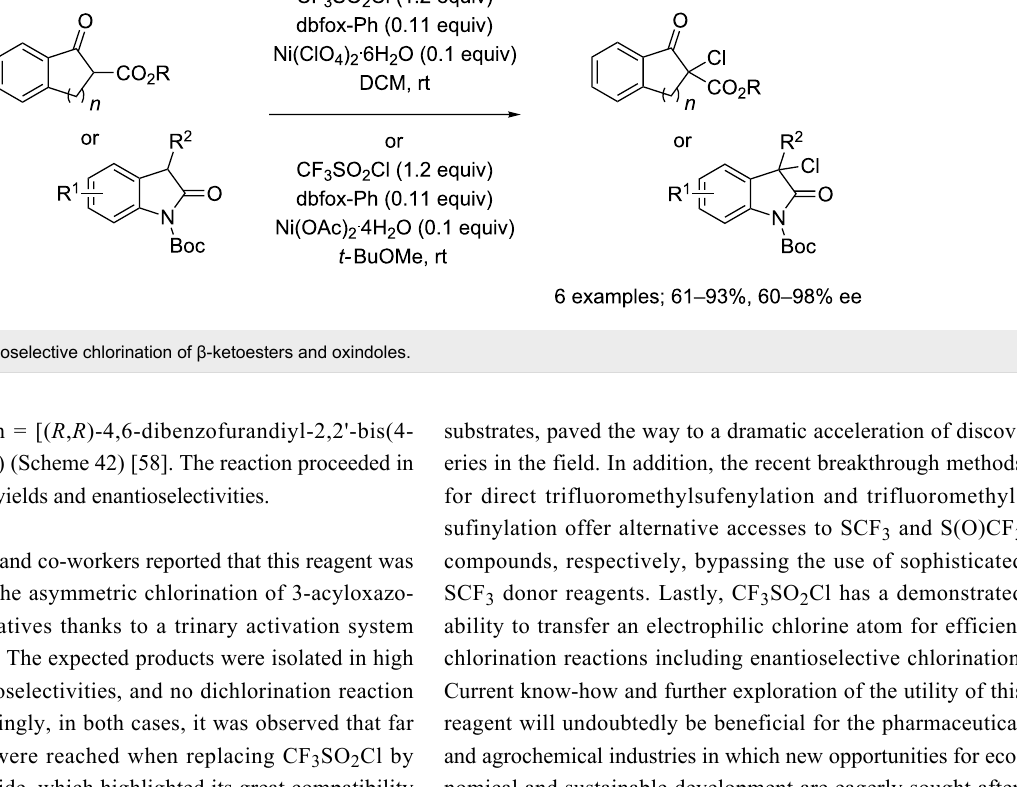
system (dbfox-Ph = [( R , R